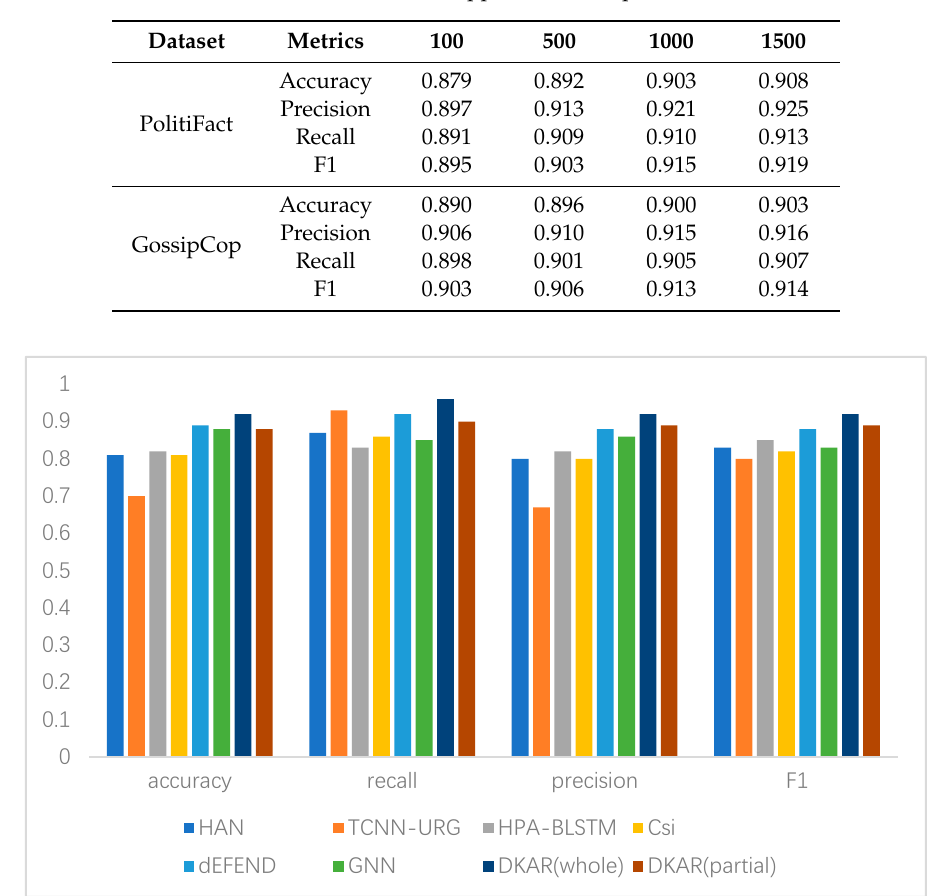
Figure 5. Performance comparison on the dataset of PolitiFact.